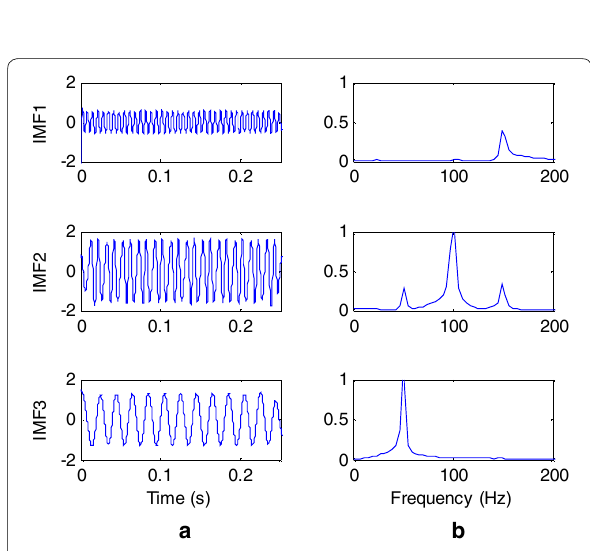
Figure 4 x ( t ) decomposed by MEMD: ( a ) waveform, ( b ) amplitude-frequency